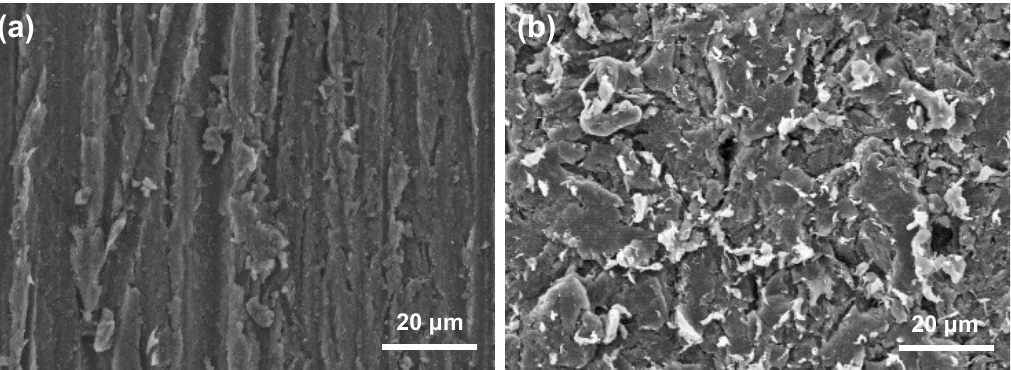
Figure 2. SEM images for the PEEK surfaces: ( a ) surface polished using emery paper and ( b ) alumina-sandblasted surface. Table 3. Results of the two-way ANOVA carried out for the TBS results between PEEK and each resin cement, both with and without thermocycling.